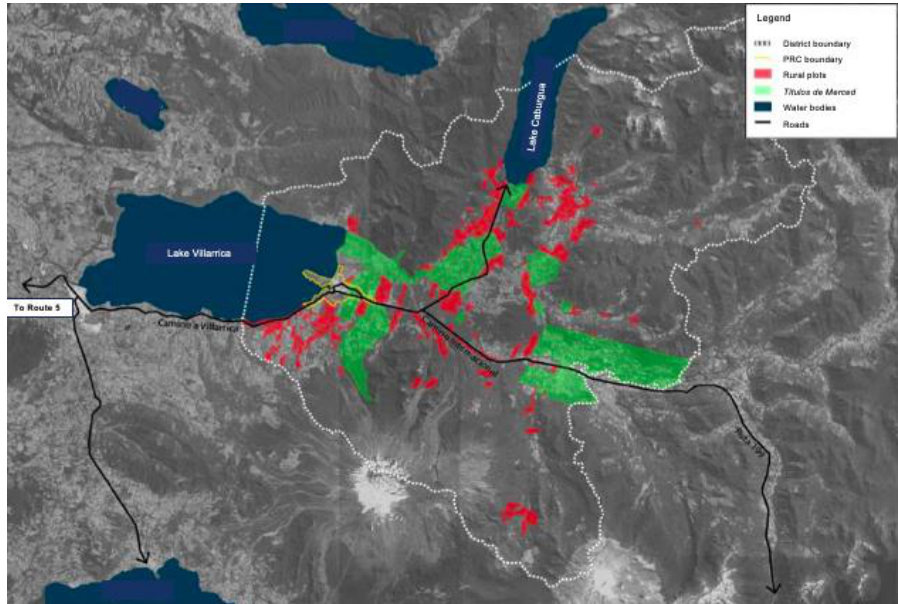
Figure 1. Urban growth through the subdivision of rural land, discounting indigenous lands. Source: